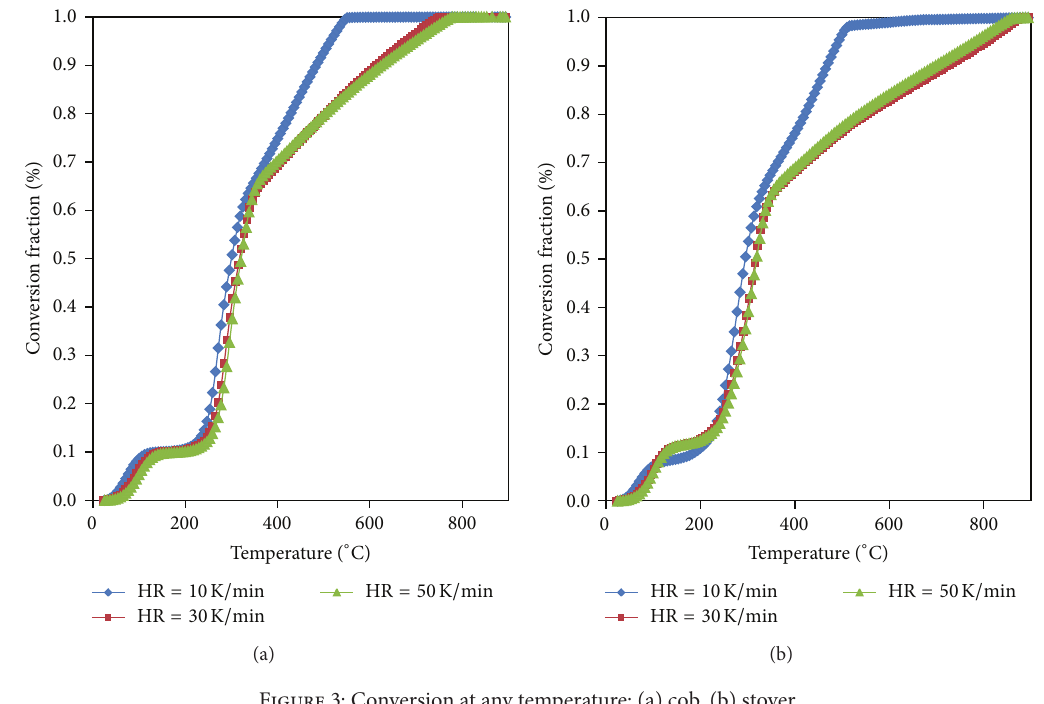
Figure 3: Conversion at any temperature: (a) cob, (b) stover.